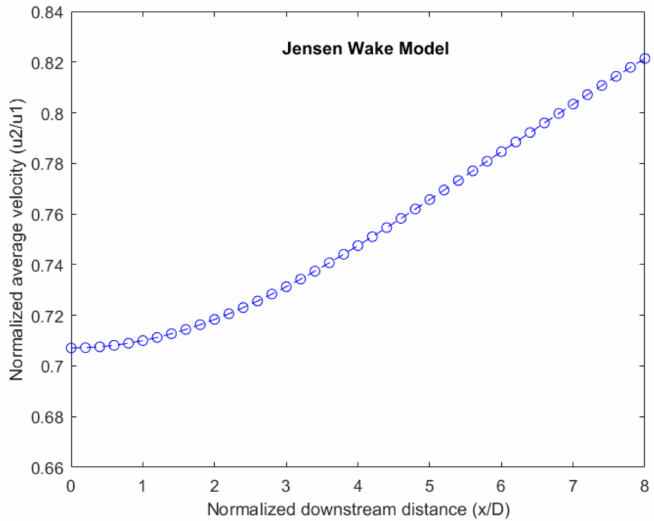
Figure 12. Normalized average velocity profile for the Jensen wake model.